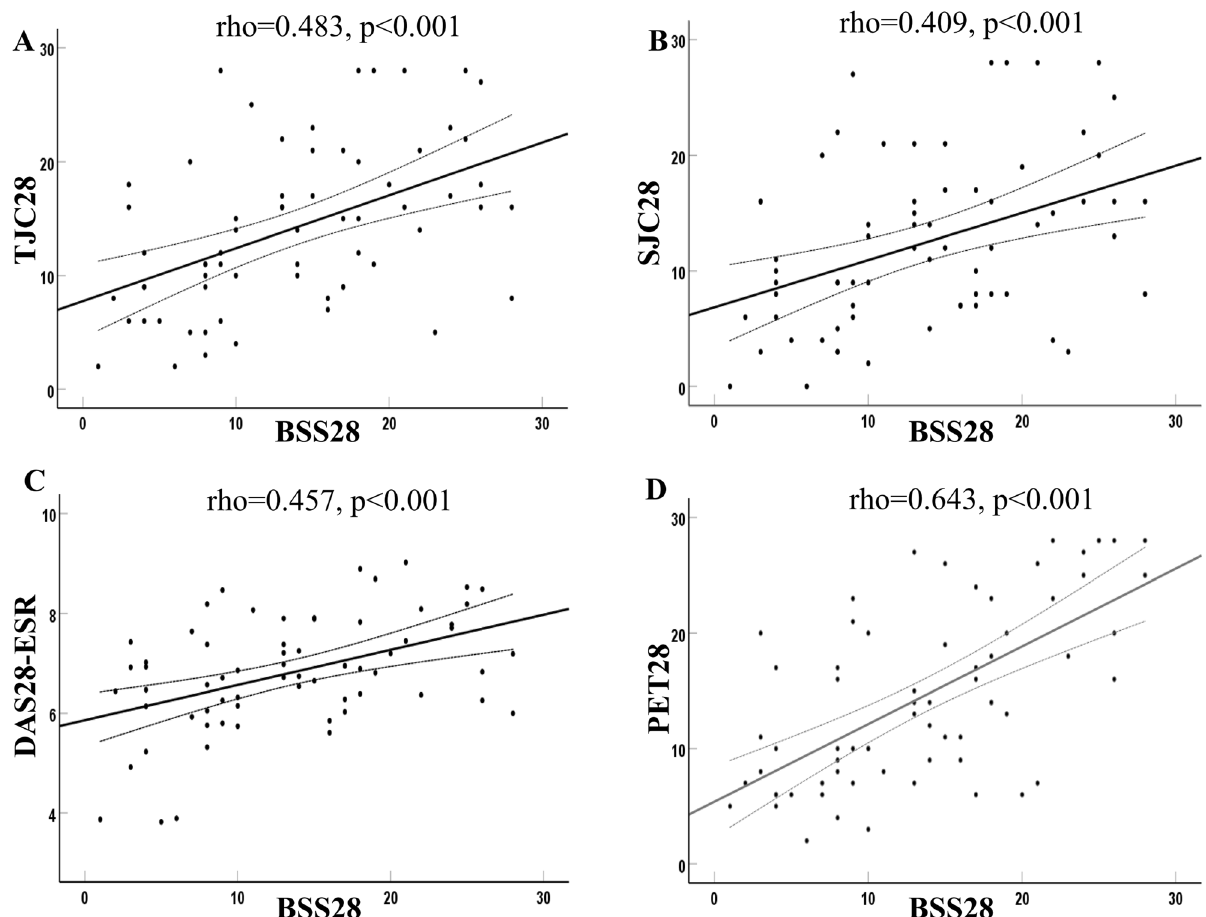
Figure 2. Correlation between positive findings in the joints assessed by PET, BS, and clinical assessment. The number of bone scintigraphy positive joints in 28-joints (BSS28) was significantly correlated with the tender joint counts in 28 joints (TJC28) (r = 0.483, p < 0.001) ( A ), the swollen joint counts in 28 joints (SJC28) (r = 0.409, p = 0.001) ( B ), DAS28-ESR (r = 0.457, p < 0.001) ( C ), and the number of PET-positive joints in 28 joints (PET28) (r = 0.643, p < 0.001) ( D ). Each symbol represents an individual data point, and the dotted lines represent the 95% confidence interval. The correlation coefficients and p values were calculated using the Pearson’s correlation test. ESR, erythrocyte sedimentation